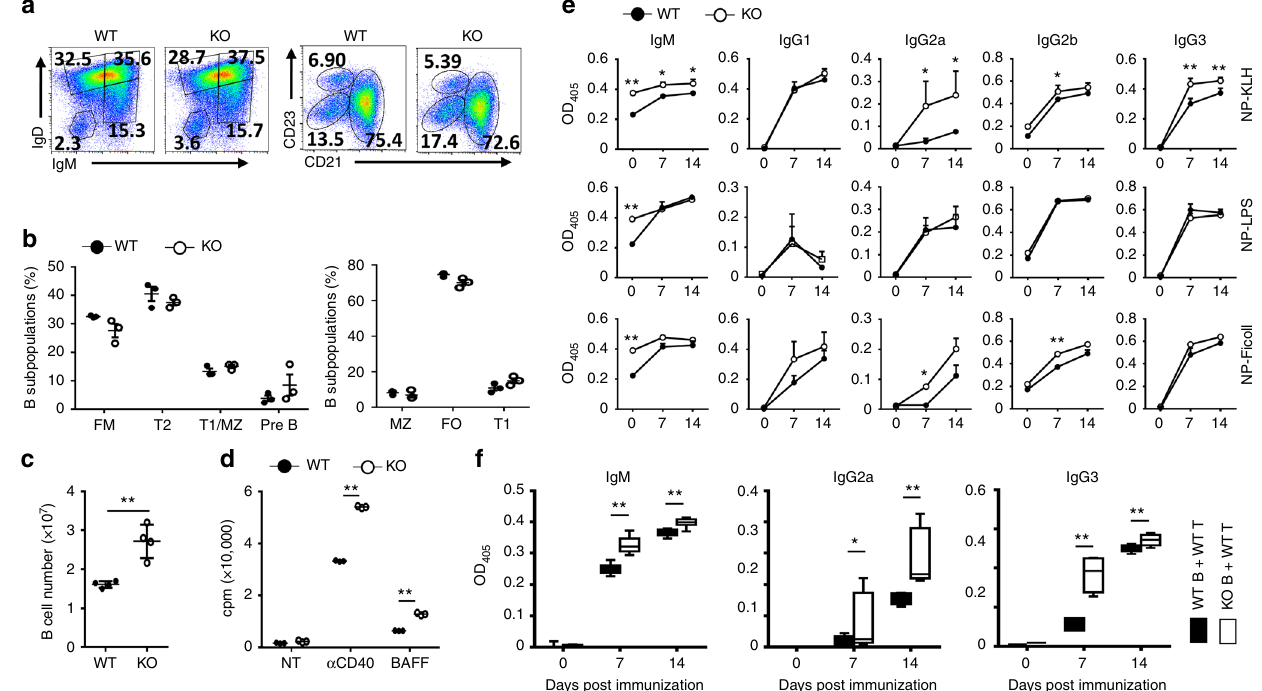
Fig. 1 Peli1 de fi ciency promotes B cell proliferation and antibody secretion. a , b Flow cytometric analysis of the percentages of B cell subpopulations in the spleens of WT and Peli1 -di fi cient mice. Data are presented as a representative plot ( a ) and summary graph ( b ). c The absolute numbers of B220 + B cells in the spleens of WT and KO mice. d Proliferation of WT and KO splenic B cells incubated in vitro for 72 h in the absence (NT) or presence of anti-CD40 ( α CD40) or BAFF, then assessed by [ 3 H]thymidine incorporation. e Enzyme-linked immunosorbent assay (ELISA) of NP-speci fi c antibody isotypes in the serum of WT and Peli1 -di fi cient mice immunized intraperitoneally with NP-KLH, NP-LPS, or NP-Ficoll. f ELISA of NP-speci fi c IgM, IgG2a and IgG3 in the serum of Rag1-di fi cient mice that transferred with WT T cells plus WT or KO B cells, and then immunized intraperitoneally with NP-KLH. Data are shown as the mean ± SEM based on three independent experiments. Two-tailed Student ’ s t- tests were performed. * P < 0.05 and ** P <